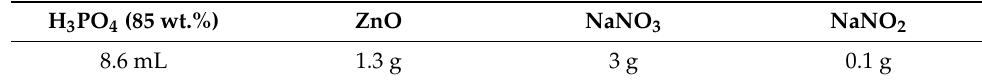
Table 2. Phosphating bath composition (for 1